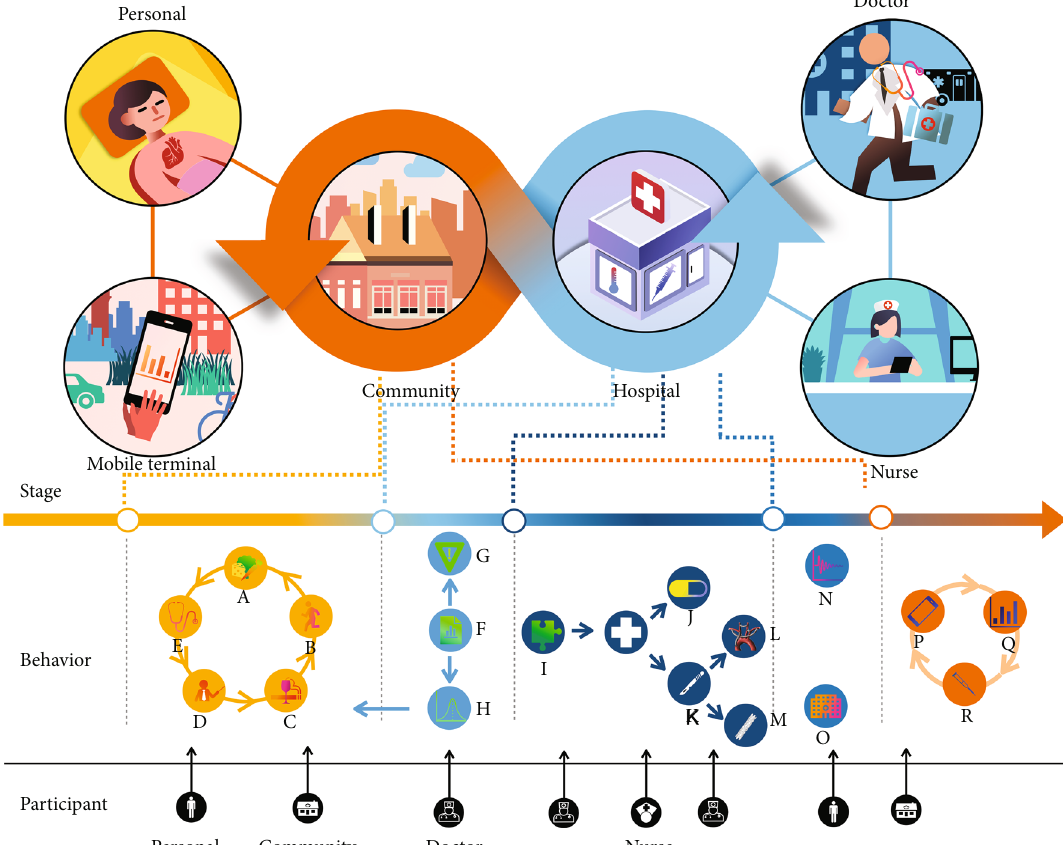
Figure 2: The prevention, treatment, and management of diabetic vascular complications. A: Diet; B: sport; C: quitting smoking and alcohol; D: health knowledge information; E: regular health examinations; F: diagnostic results; G: report individual risk factors; H: aggregate data analyses; I: treatment plans; J: drugs; K: surgery; L: bypass surgery; M: percutaneous coronary intervention; N: